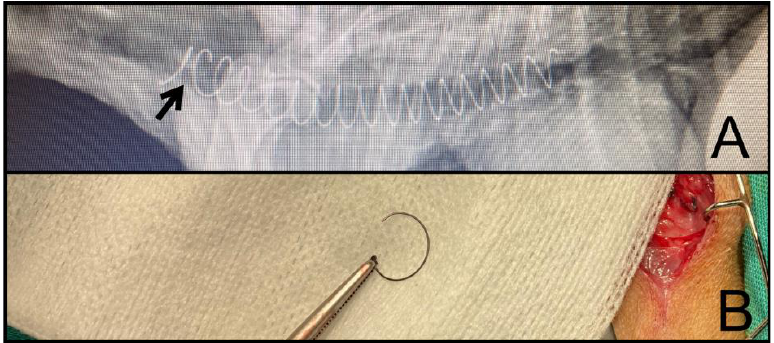
Figure 3. ( A ) Radiography of the fractured MSS. ( B ) Fragment removed after 220 days. MSS: Metallic spiral stent.